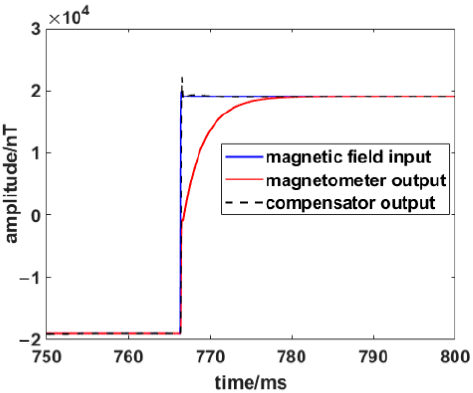
Figure 14. Output of the fluxgate magnetometer after dynamic compensation.